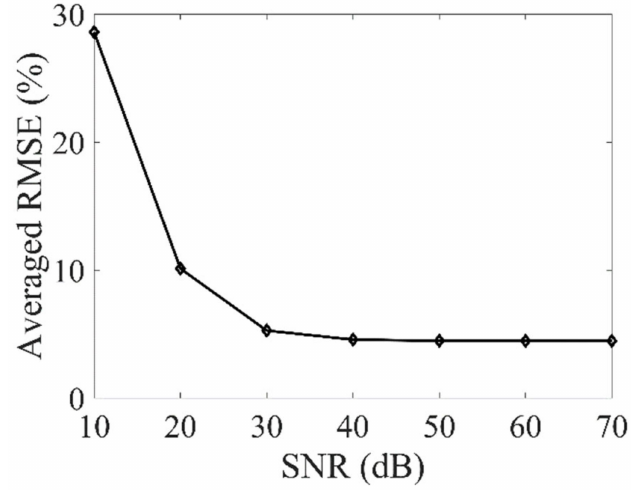
Figure 11. The averaged RMSE under different measurement SNR.